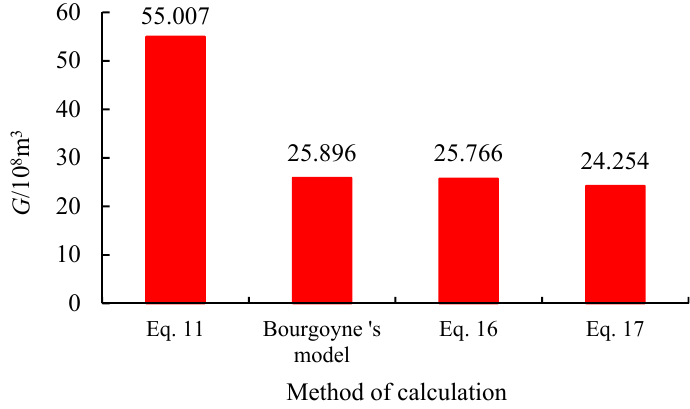
Figure 7. Comparison diagram of dynamic reserves obtained by three kinds of methods.